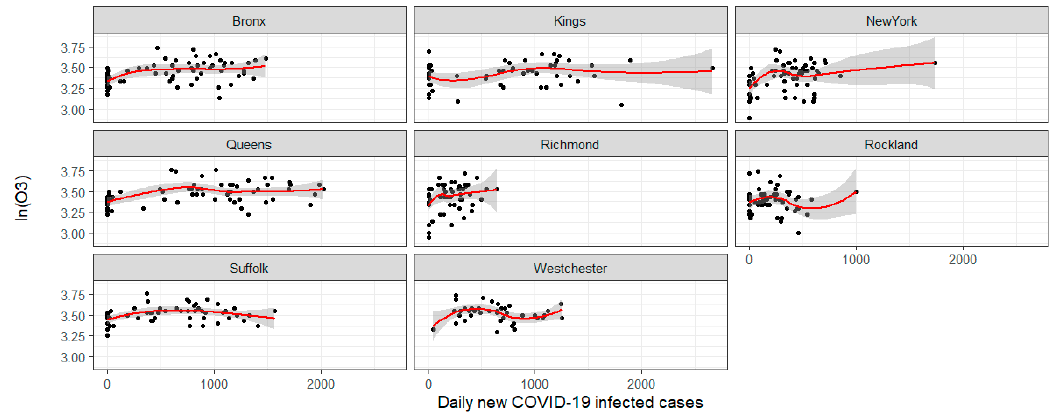
in natural logarithmic values for individual counties.